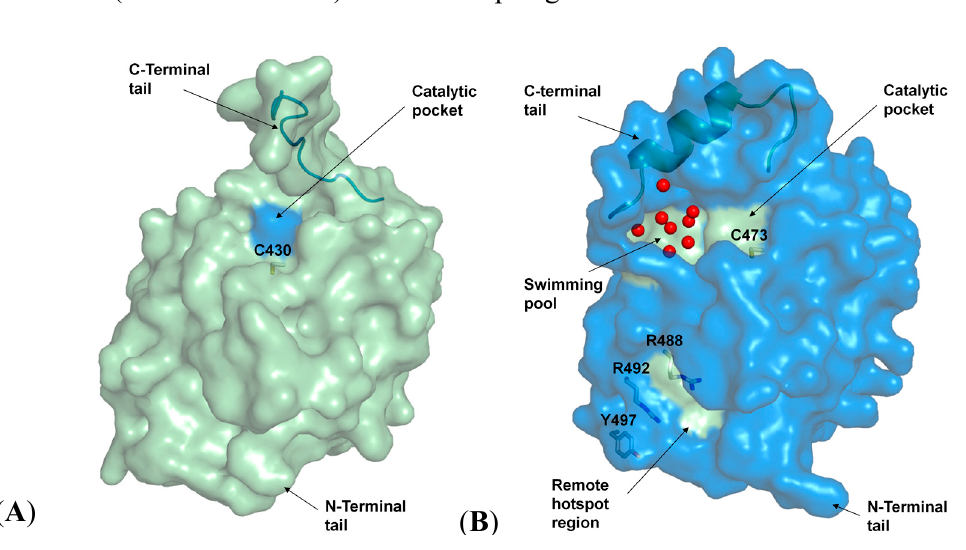
Figure 1. Structures and domains of CDC25A and CDC25B. ( A ) Surface view of CDC25A (palegreen). The catalytic site is indicated in blue marine. The C-terminal tail (residues 484-495) is shown in palegreen cartoon. ( B ) Surface view of CDC25B (blue marine). The catalytic site and the adjacent “swimming pool” pocket are indicated in palegreen. The water molecules are represented as red spheres. The hotspot residues (R488, R492 and Y497), which govern the association with the protein substrate, are shown in blue sticks. The remote hotspot region is highlighted in palegreen. The α -helical C-terminal tail (residues 531–550) is shown in palegreen